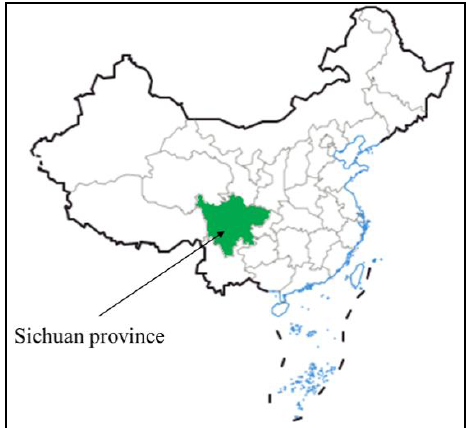
Figure 3. Boundaries of Sichuan province in China.